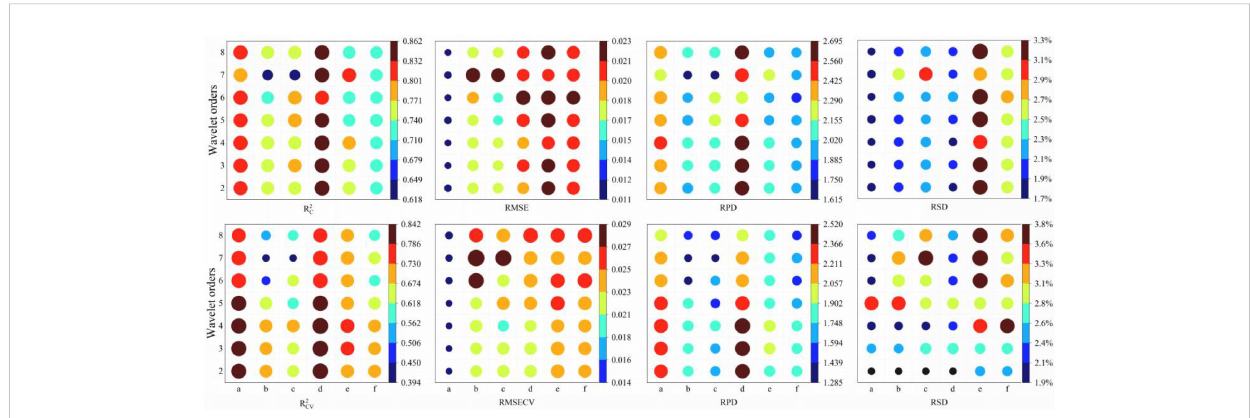
FIGURE 4 Results of PLS models for wood density with different wavelet orders. (a – f) are Tilia tuan Szyszyl ., Acer mono Maxim, Chinese white poplar (Jilin), Japanese elm, Chinese white poplar (Heilongjiang), and Dahurian larch,